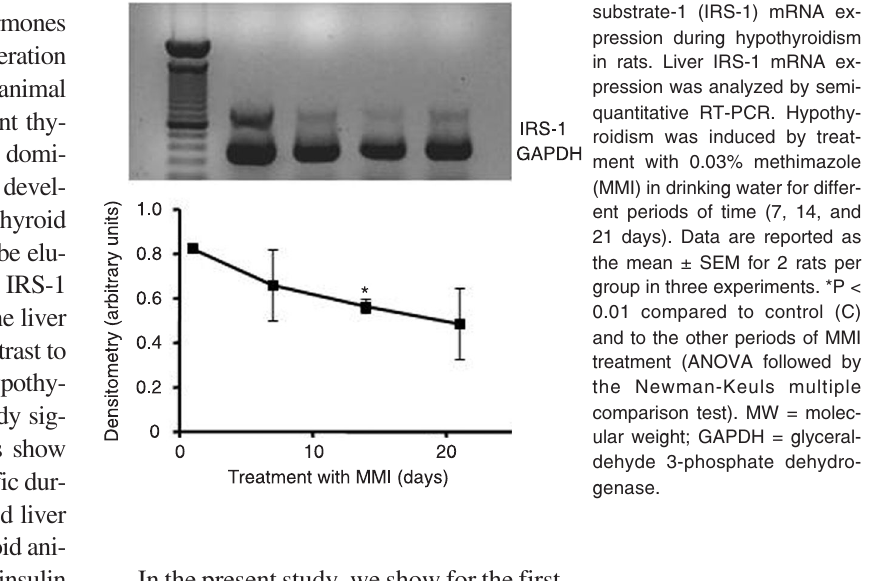
Figure 3. Liver insulin receptor substrate-1 (IRS-1) mRNA ex- pression during hypothyroidism in rats. Liver IRS-1 mRNA ex- pression was analyzed by semi- quantitative RT-PCR. Hypothy- roidism was induced by treat- ment with 0.03% methimazole (MMI) in drinking water for differ- ent periods of time (7, 14, and 21 days). Data are reported as the mean ± SEM for 2 rats per group in three experiments. *P < 0.01 compared to control (C) and to the other periods of MMI treatment (ANOVA followed by the Newman-Keuls multiple comparison test). MW = molec- ular weight; GAPDH = glyceral- dehyde 3-phosphate dehydro-